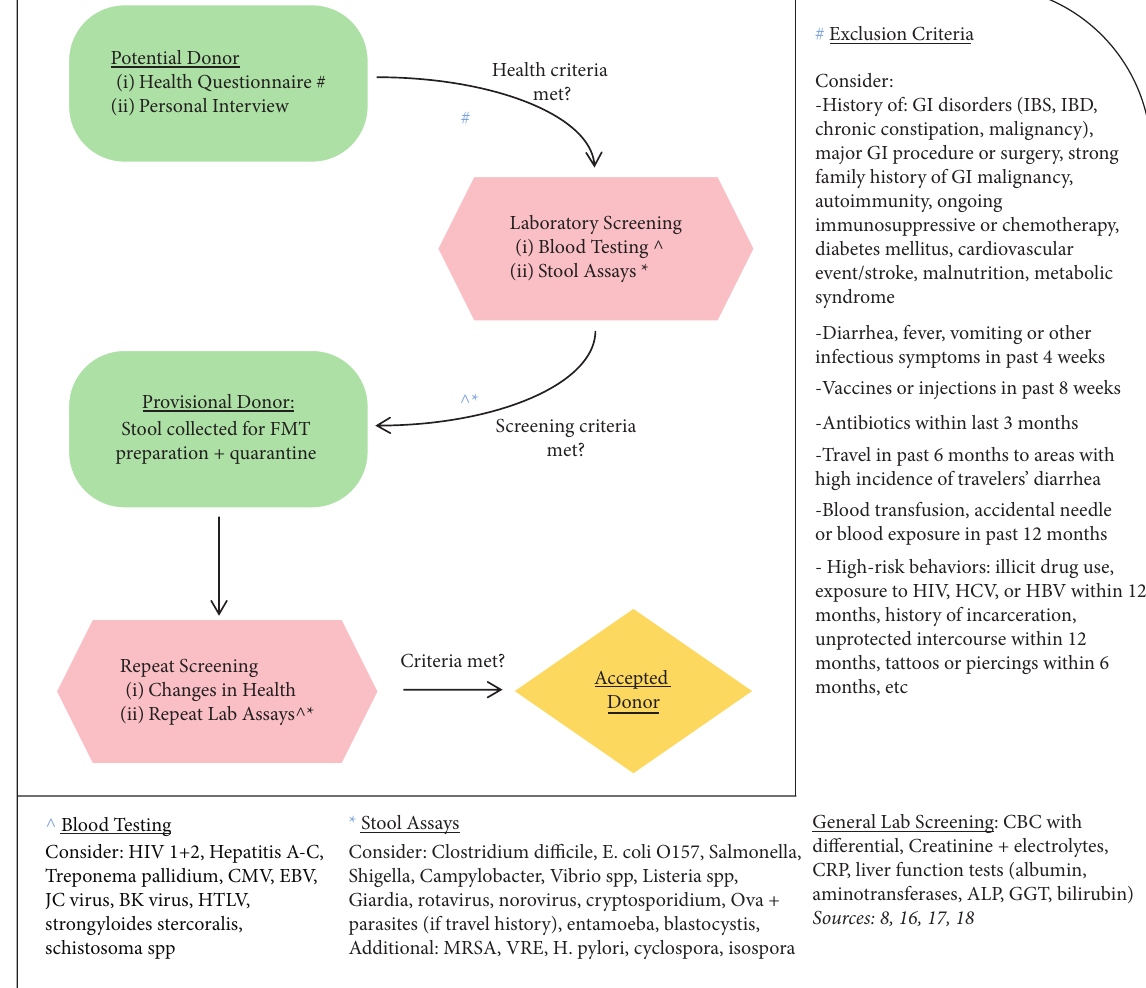
Figure 1: Summary of the FMT donor screening process: including the review of exclusion criteria, blood testing, and stool assays undergone by potential donors prior to authorization as an accepted donor. Note that these criteria are to be used as guidance for donor selection. However, this list of screening assays is not exhaustive, and additional testing may be considered in certain clinical